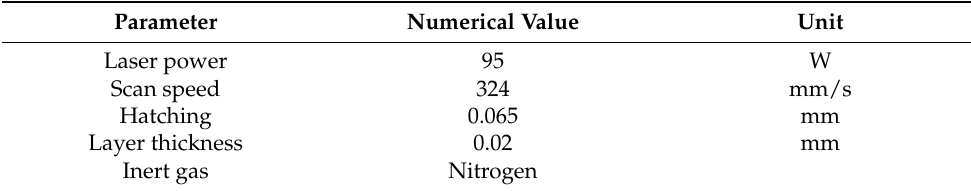
Table 1. Parameters used for manufacturing the samples.